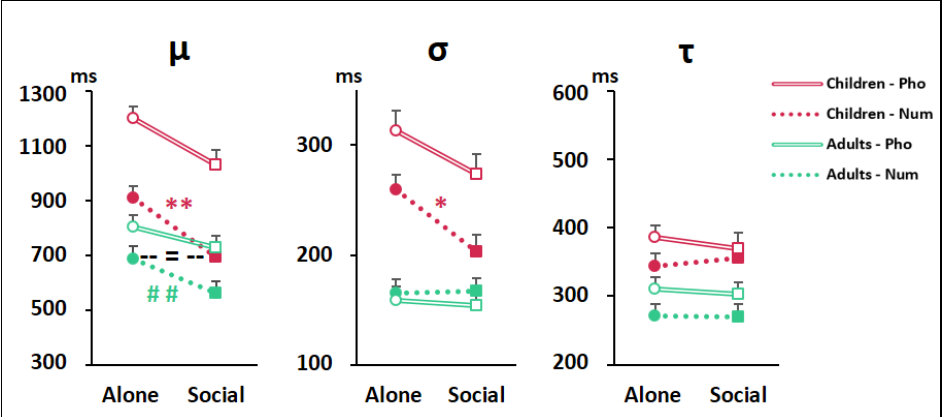
Figure 5. Ex-Gaussian decomposition of RTs into average performance ( µ ), variability in performance ( σ ), or extremes in performance ( τ ). Data points are means + SEM. Symbols denotes results from Student’s t -tests with the Bonferroni adjustment for multiple comparison: the asterisks indicate differences between the Social and Alone conditions (* p < 0.05, ** p < 0.01). The = sign underscores the lack of difference between children tested with a peer and adults tested alone for the µ